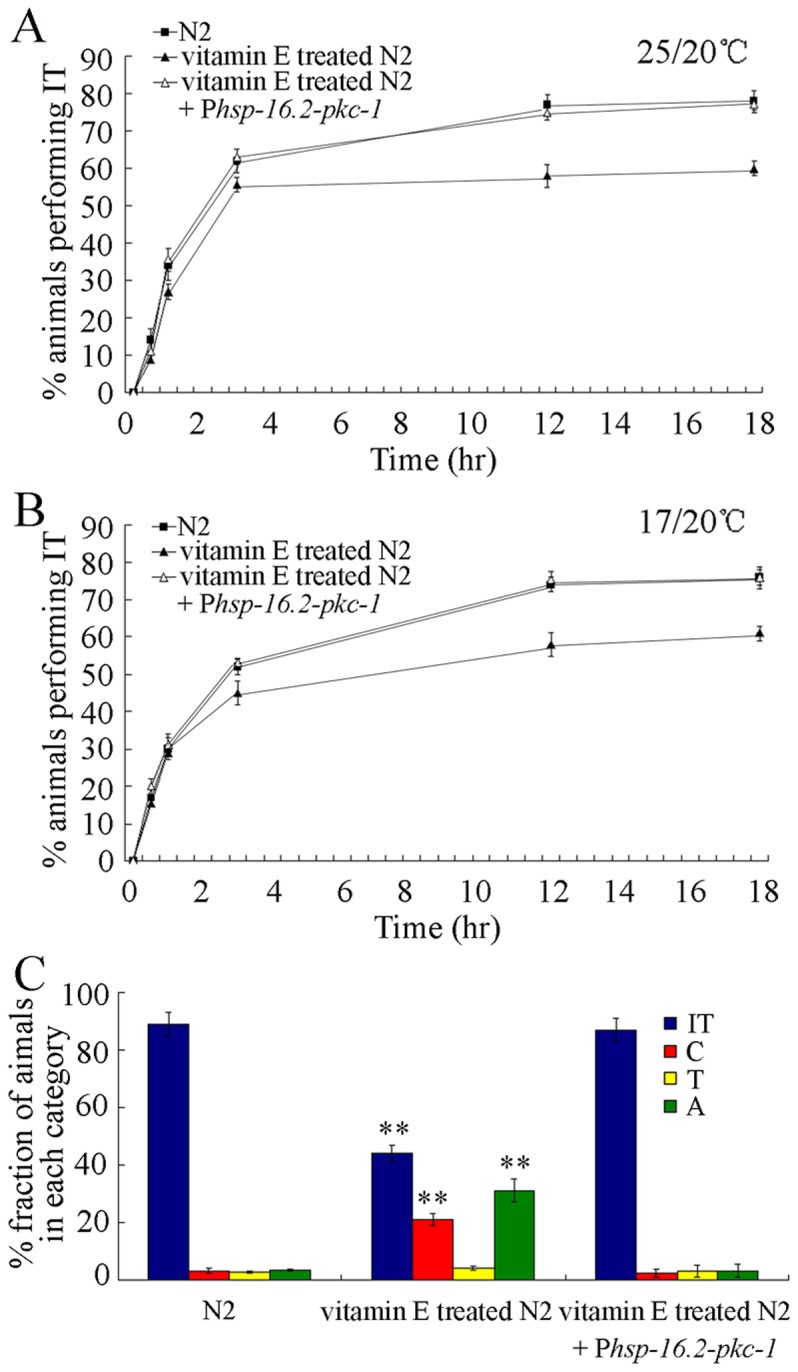
Promotion of synaptic transmission effectively retrieved deficits in learning and thermotaxis behaviors in nematodes treated with 400 µg/mL of vitamin E.(A) Promotion of synaptic transmission effectively retrieved deficits in thermotaxis learning behavior in nematodes treated with 400 µg/mL of vitamin E as monitored by 25/20°C thermotaxis assay. (B) Promotion of synaptic transmission effectively retrieved deficits in thermotaxis learning behavior in nematodes treated with 400 µg/mL of vitamin E as monitored by 17/20°C thermotaxis assay. (C) Promotion of synaptic transmission effectively retrieved deficits in thermotaxis in nematodes treated with 400 µg/mL of vitamin E. In the thermotaxis assay system, movement to 25°C was scored as thermophilic (T); movement to 17°C was scored as cryophilic (C); movement across the thermal gradient (17°C/25°C) was scored as athermotactic (A); movement at 20°C was scored as isothermal tracking behavior (IT). Data are expressed as mean ± SEM. **p<0.01 vs. N2.